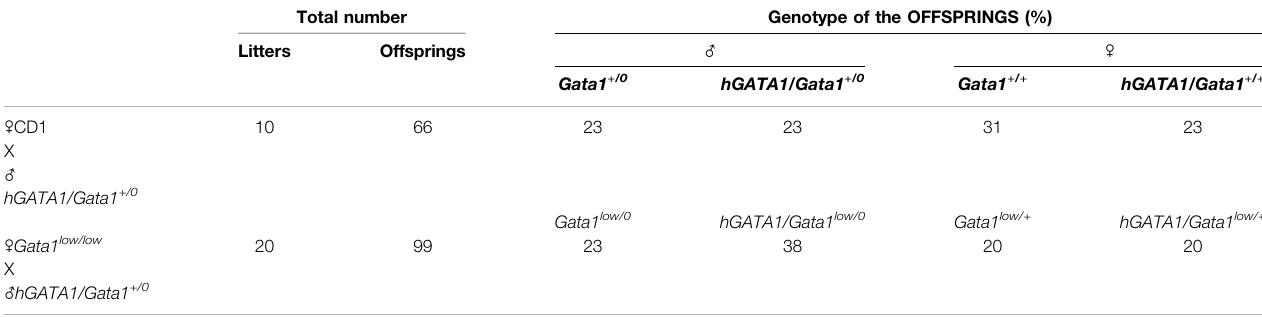
TABLE1| SummaryoftheoffspringsofthematingofCD1or Gata1 low/low mutantswiththe hGATA1 transgenicmice. hGATA1/Gata1 +/0 maleswerecrossedwitheitherCD1 ( Gata1 +/0 ) or Gata1 low/low females and their progeny genotyped. All the experiments described in the paper were carried out on Gata1 low/0 and Gata1 +/0 males, containing or not the hGATA1 transgene, highlighted in